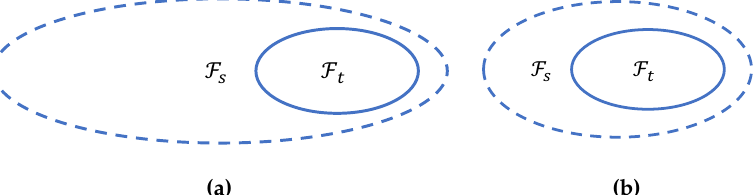
Figure 4. Adaptive domain randomization adjusts the probability distributions of sampling model parameters and converts the source domain from ( a ) to ( b